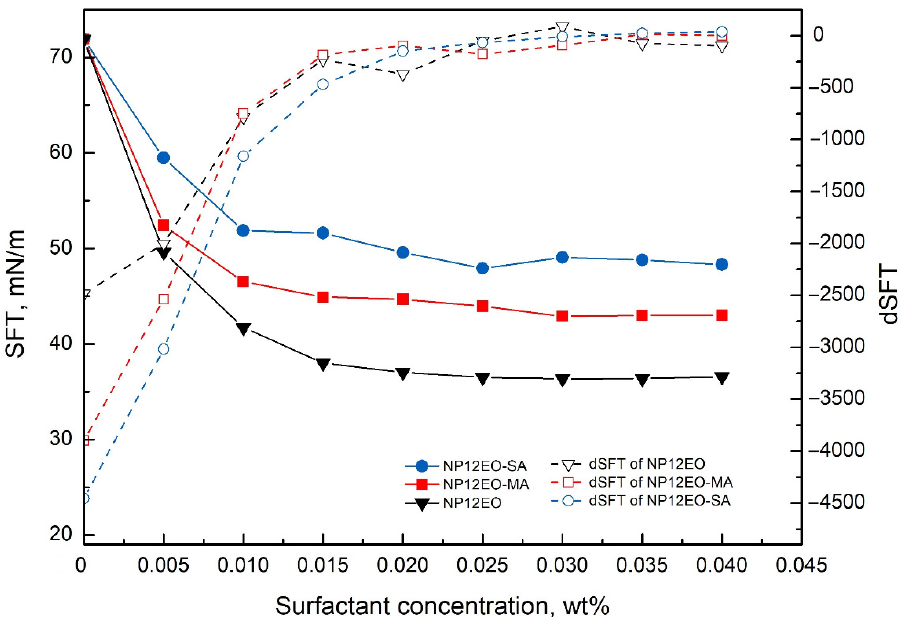
Figure 5. The surface tension of NP12EO-SA, NP12EO-MA, and NP12EO surfactant solutions on distilled water.